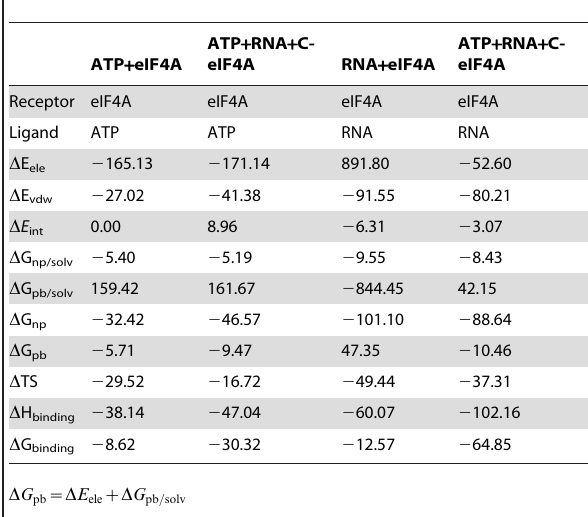
Table 1. MM-PBSA free energy (kcal ? mol 2 1 ) components for the ATP + eIF4A, RNA + eIF4A and ATP + RNA + C-eIF4A models.